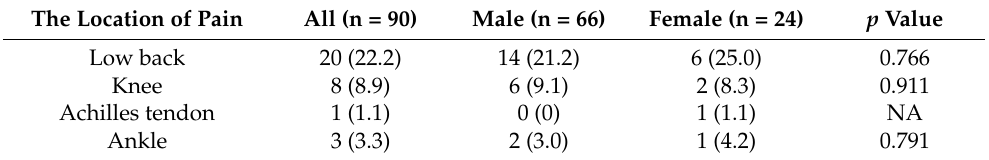
Table 3. Details of pain detected in the spine and lower extremities.